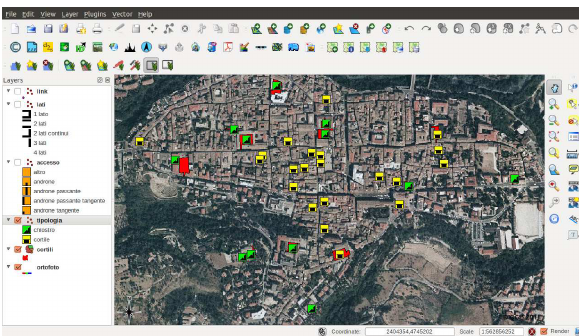
Figure 7. Links to photographic resources 3.3.3.3. THE CONSTRUCTION OF THE 3D